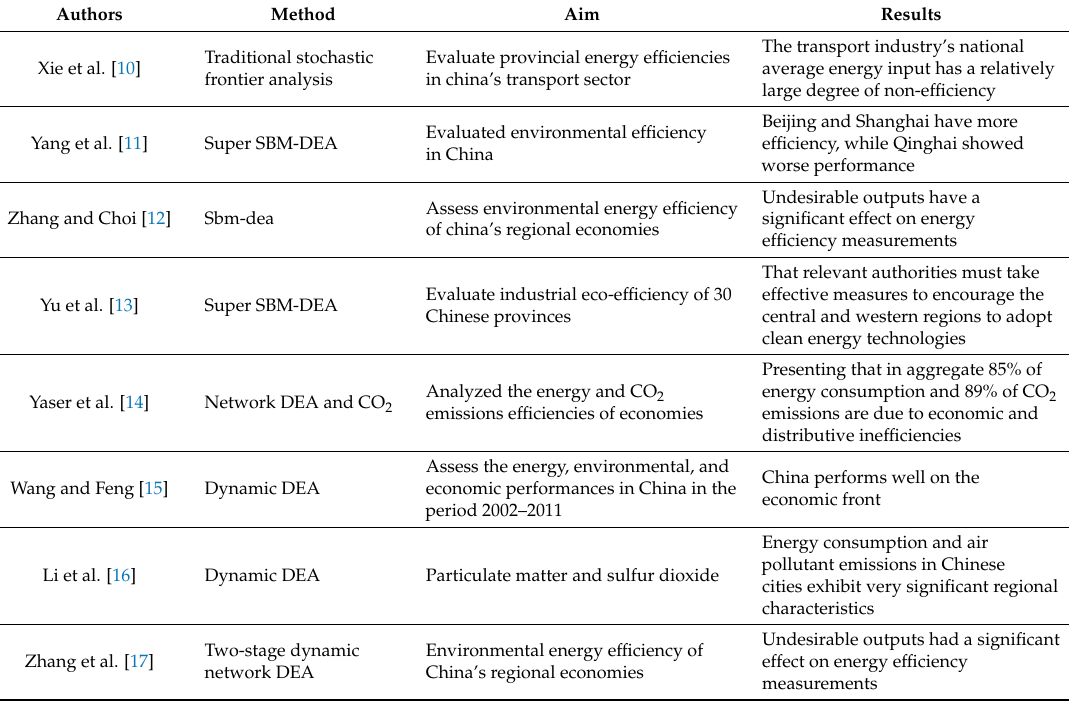
Table 1. The main research on energy and environmental performances.